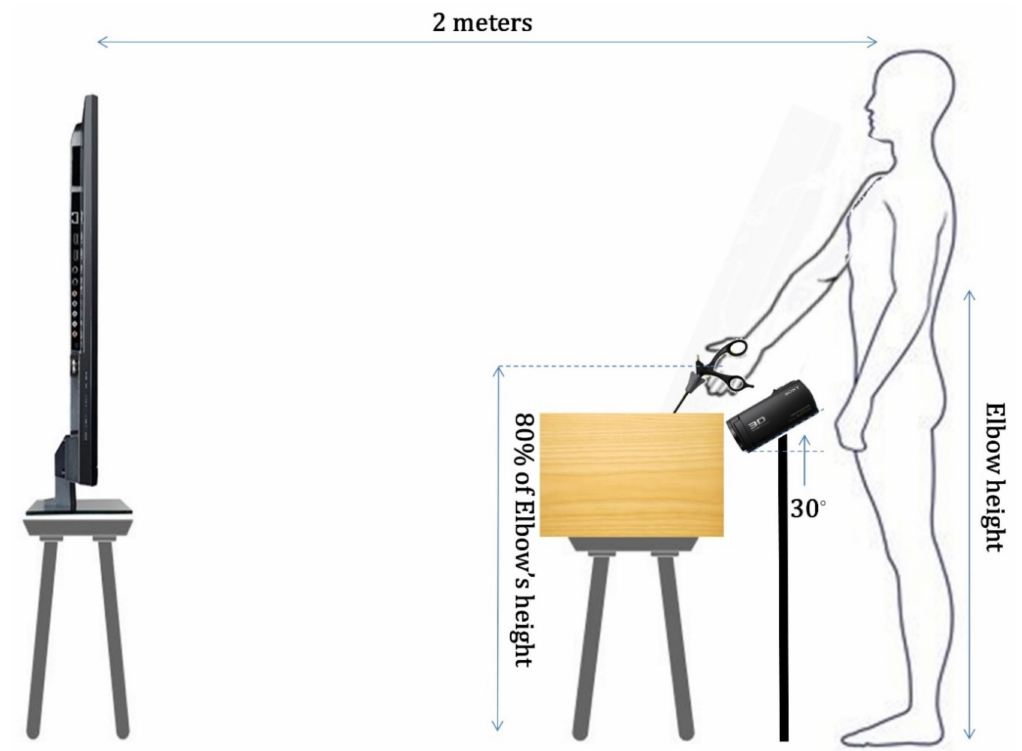
Figure 1. Experimental